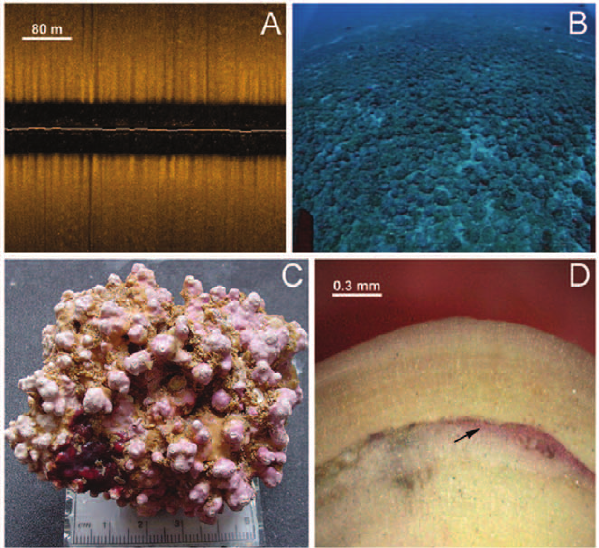
Figure 1. Selected aspects of rhodolith beds and individual rhodoliths. (A) SSS sonogram showing flat and highly reflective bottom typical of rhodolith beds. (B) ROV image showing the typical physiognomy of the rhodolith beds. (C) Individual rhodolith consisting primarily of Lithothamnion crispatum with high proportion of live tissue. (D) Superficial view of a rhodolith section observed via a stereomicro- scope, showing the reddish band (arrow) corresponding to the staining performed six months